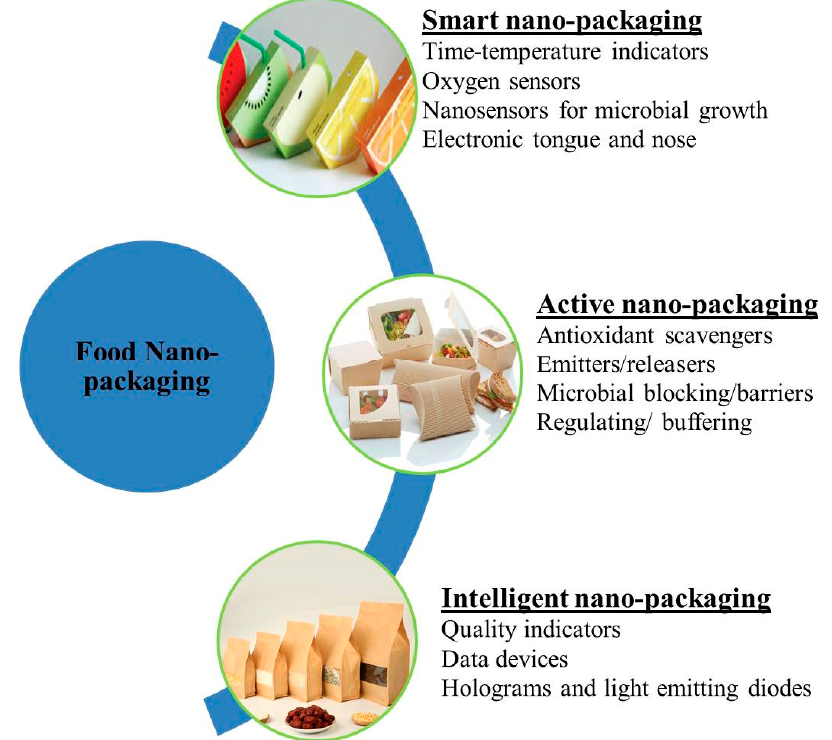
Figure 4. Classification of food nanopackaging.